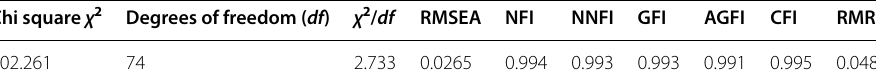
Table 5 The general model fit statistics Chi square χ 2 Degrees of freedom ( df ) χ 2 / df